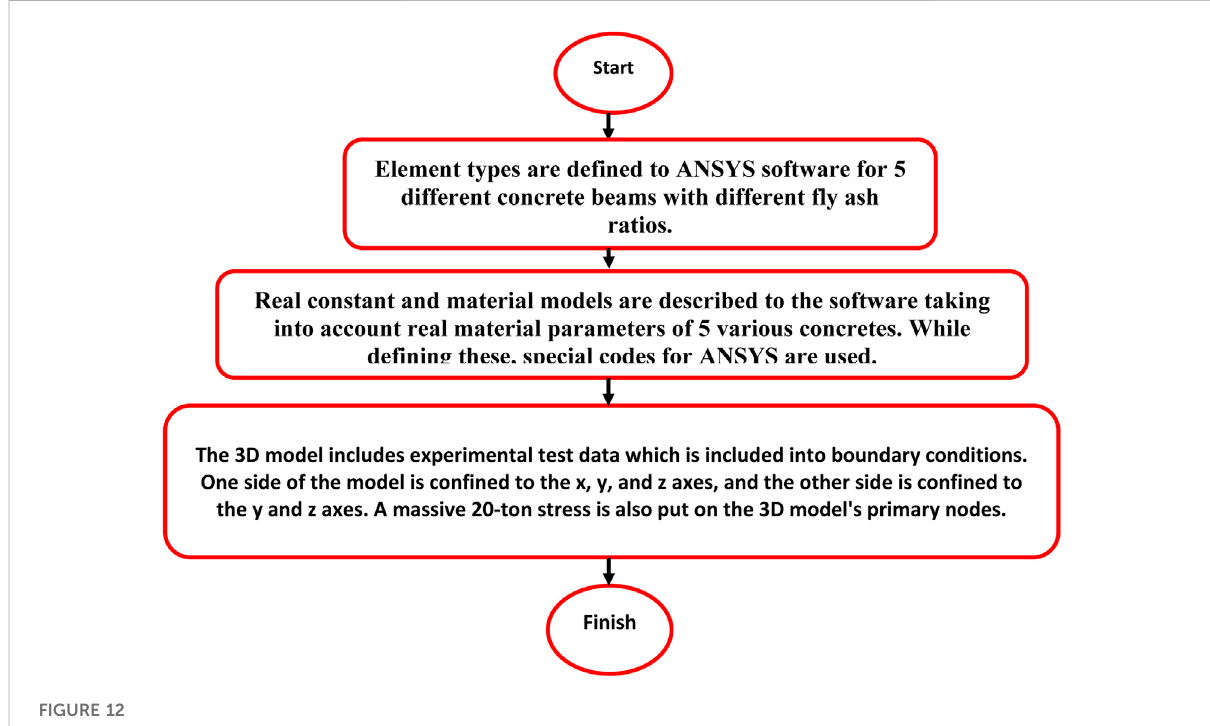
FIGURE 12 Numerical analysis algorithm for numerical